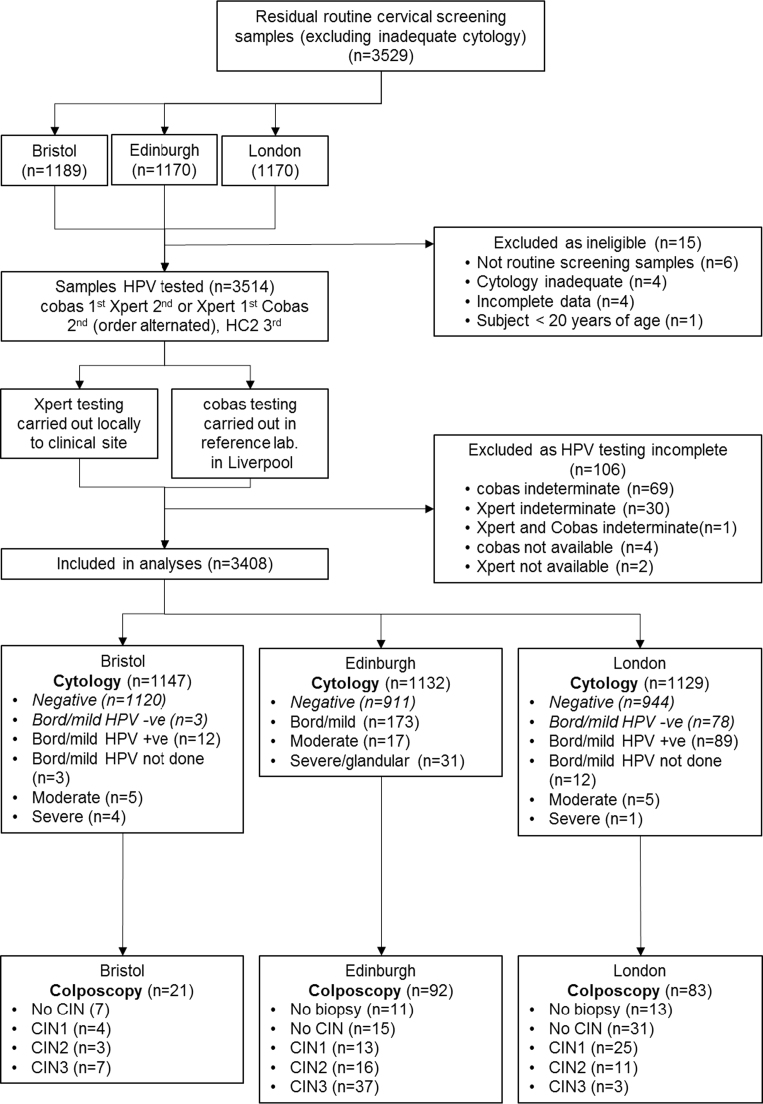
Flowchart of women in this screening study.